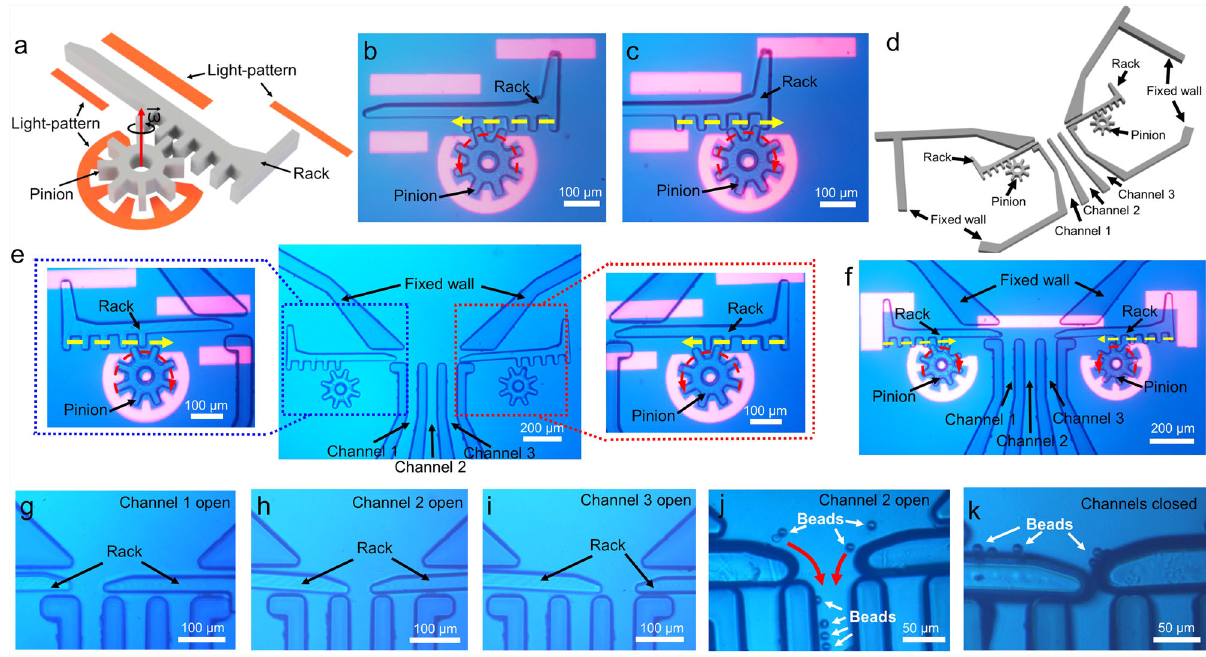
Fig. 6 Micromachine 3: the micro-rack-and-pinion. a Schematic of a micro-rack-and-pinion system. b , c Frames from Supplementary Movie 15 illustrating a micro-rack-and-pinion system in operation, in which rotating the pinion counterclockwise or clockwise can make the rack translate to the left or the right, respectively (with the direction indicated by yellow dashed arrows). d Schematic of a permanent microchannel structure designed to interface with micro- rack-and-pinion systems. e Microscope images of a micro fl uidic valve formed from two micro-rack-and-pinion systems that can be individually controlled. f – i Frames from Supplementary Movie 15 illustrating how two rack and pinion structures can work together to choke and isolate fl ow in the microchannels. j , k Frames from Supplementary Movie 16 illustrating the use of micro-rack-and-pinion structures as valves to control the movement of 10- μ m-diameter microbeads in micro fl uidic channels. In ( b , c , e , f ), red and yellow dashed lines with arrowheads represent the motion of the (active) pinions and the (passive) racks, respectively. In ( j ), red lines with arrowheads represent the moving direction of the